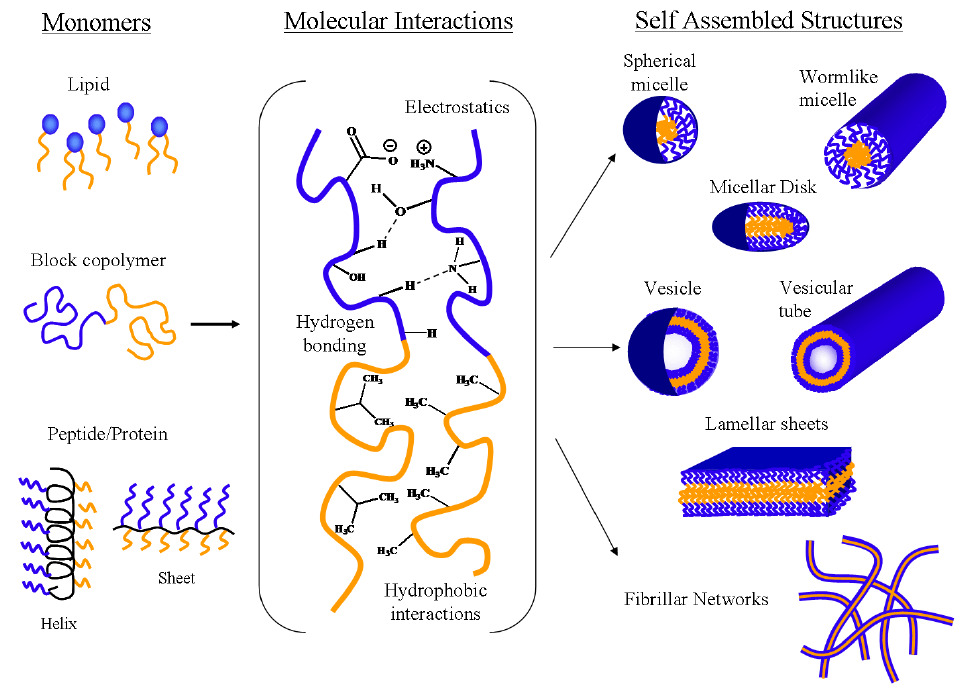
Figure 3. Most common self-assembled structures made from surfactants, block copolymers, and/or peptides/proteins (Reproduced with permission from [2]; Copyright Elsevier,